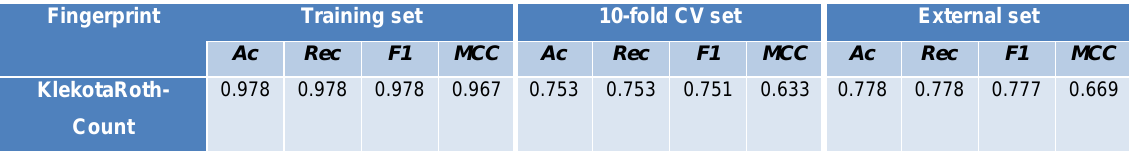
Table 5: Summary of performance for random forest model built with tuned hyperparameters (n_esti- mators =150, max_features=5, random